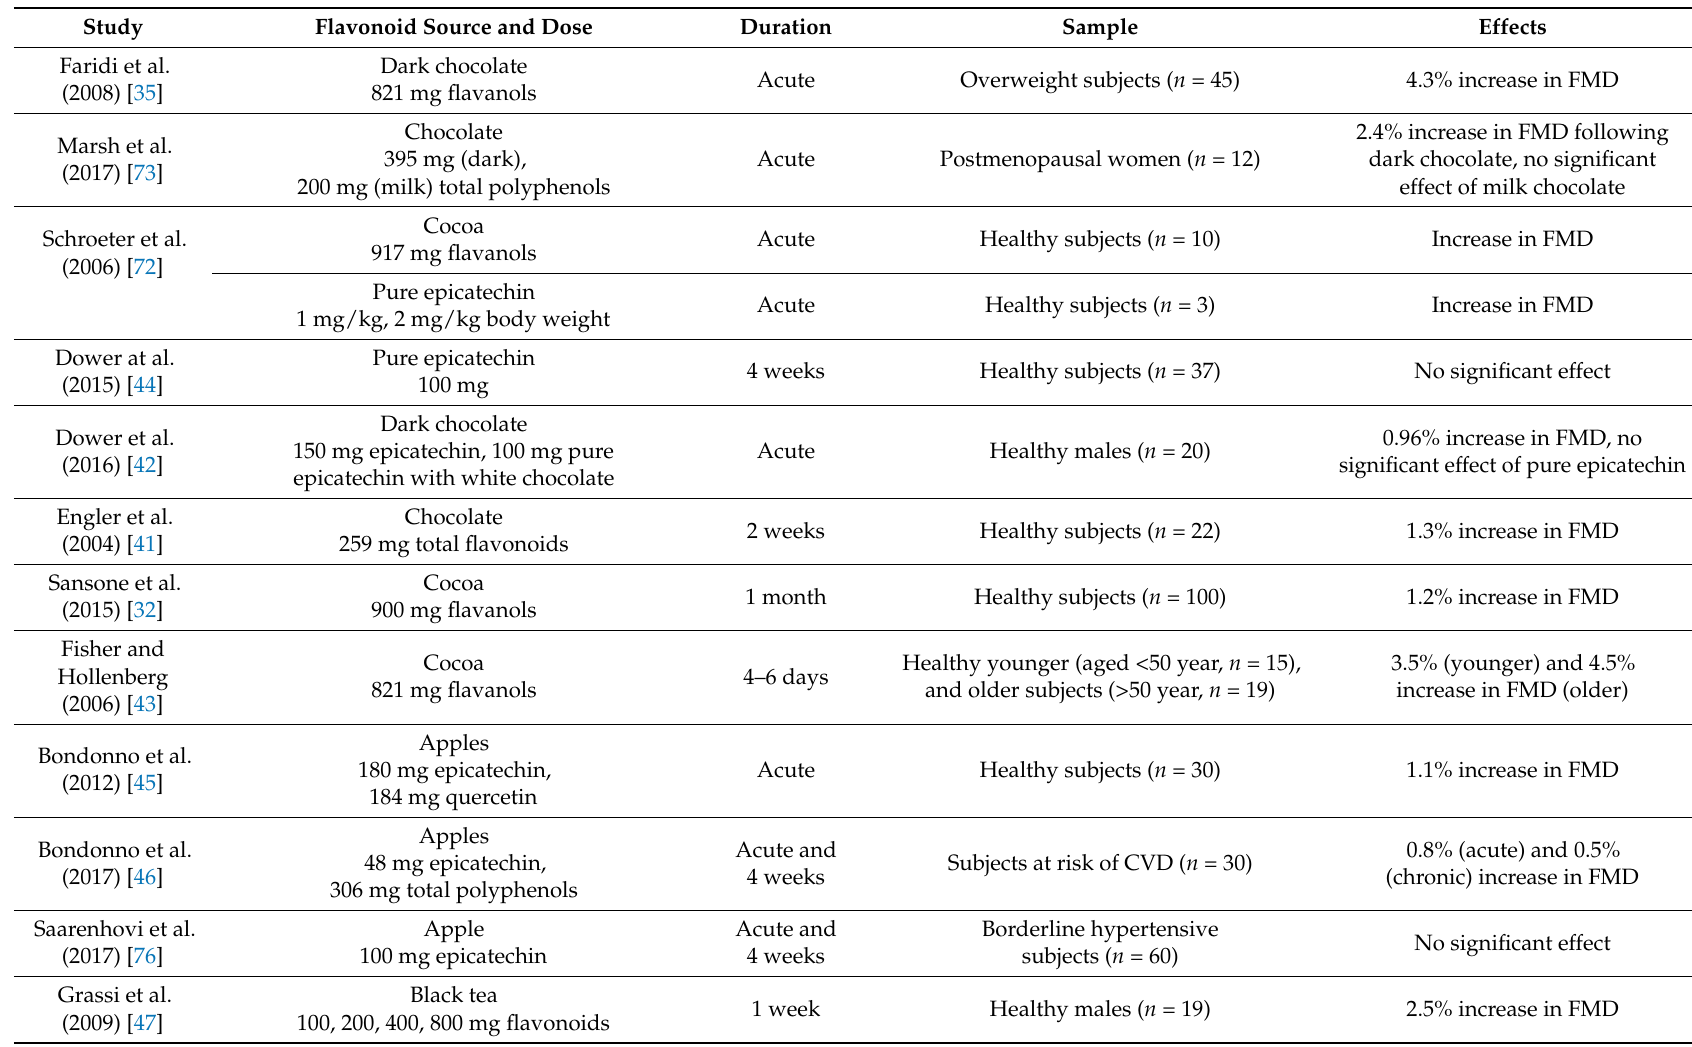
Table 2. Summary of studies investigating the effect of flavonoids on endothelial